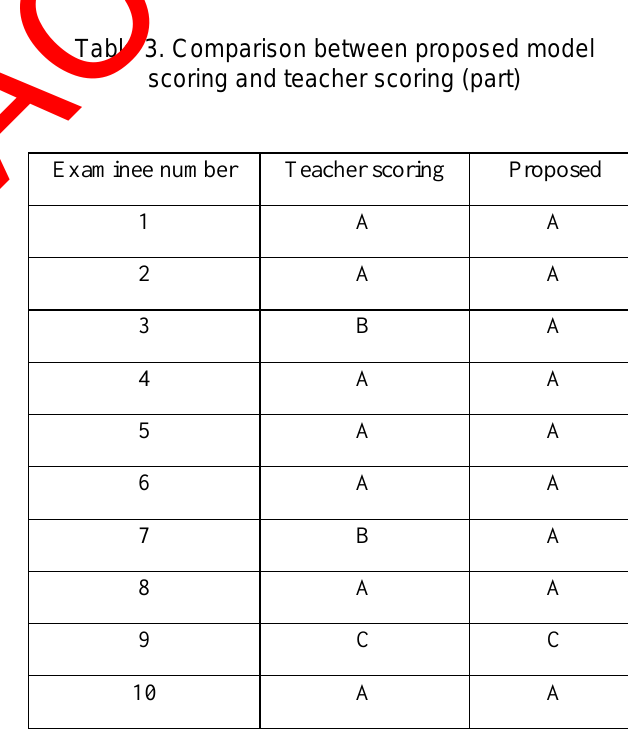
Table 3. Comparison between proposed model